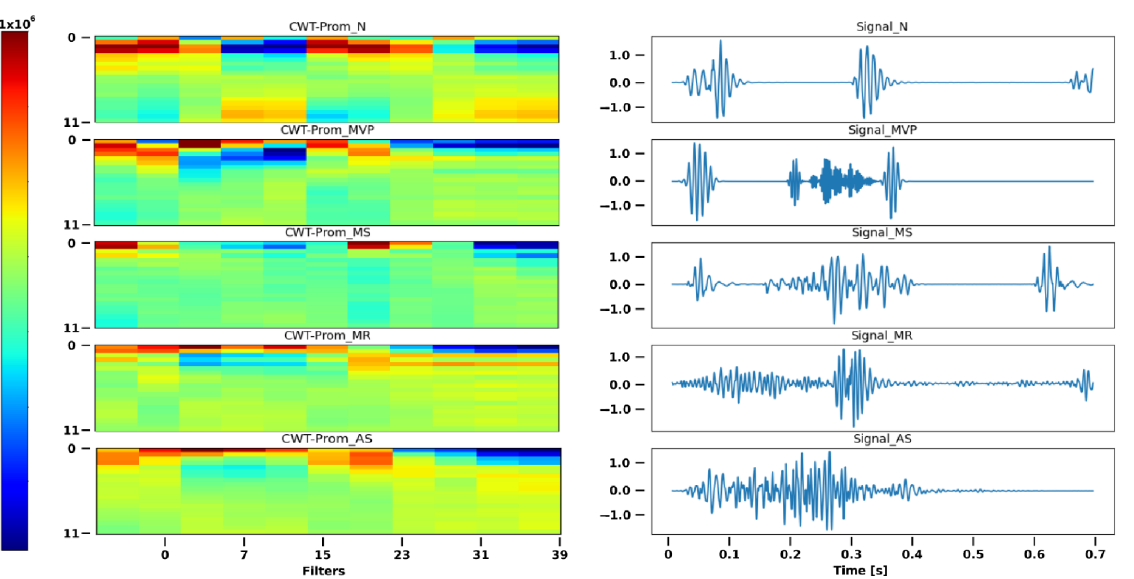
Figure 4. Results using DWT: displaying the average value of the MFFCs for each class set on a colorimetric scale. A normalized PCG record that was randomly chosen from each sample (Reused with permission [9].